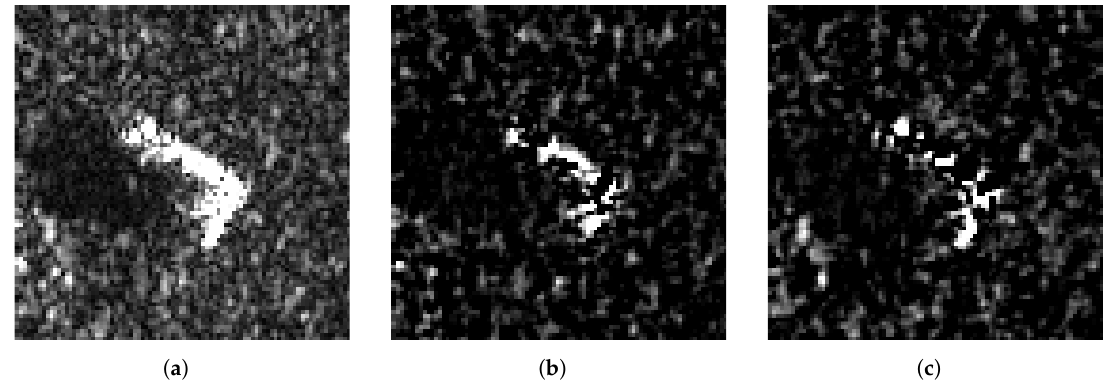
Figure 6. Input data of the amplitude-real-imaginary CNN: ( a ) Amplitude layer; ( b ) Real layer; ( c ) Imaginary layer.